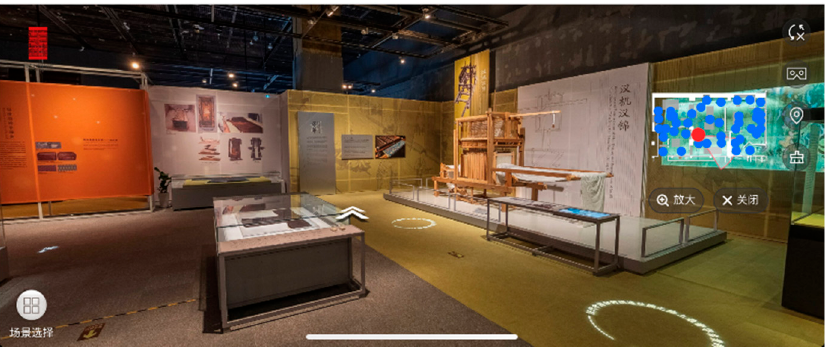
Figure 3. Virtual exhibition hall.